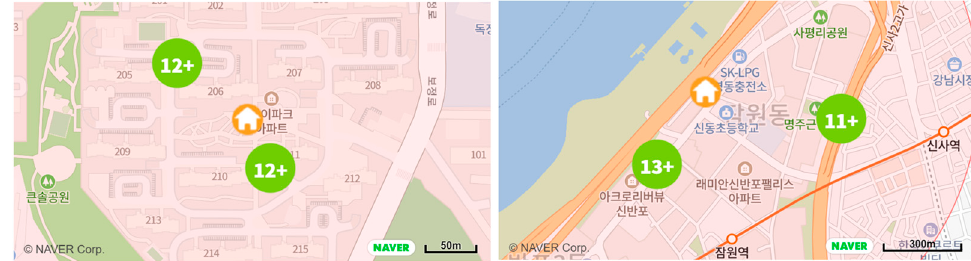
Figure 13. Sample cases of representing two location clusters while staying at home.